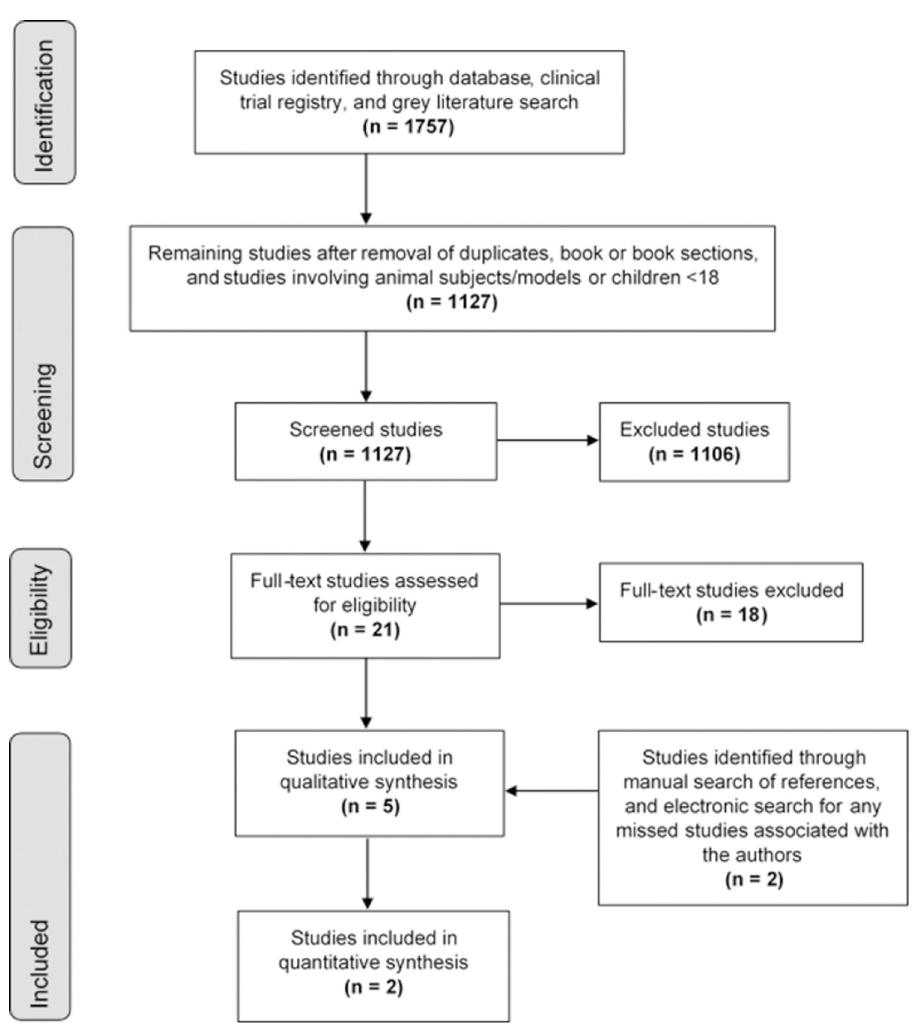
Fig 1. Overview of study selection. The diagram summarizes search results between January 1, 2009, and May 14, 2020. MEDLINE found 326 records, Embase 723 records, Cochrane Central 20 records, Web of Science Core Collection 131 records, Scopus 169 records, Google Scholar 200 records, and International Clinical Trials Registry Platform (World Health Organisation) 23 records. The search was updated during July and August 2020 by hand searching gray literature, identifying 165 records. All 1127 records were screened for eligibility, with 2 new studies meeting the inclusion criteria identified in January